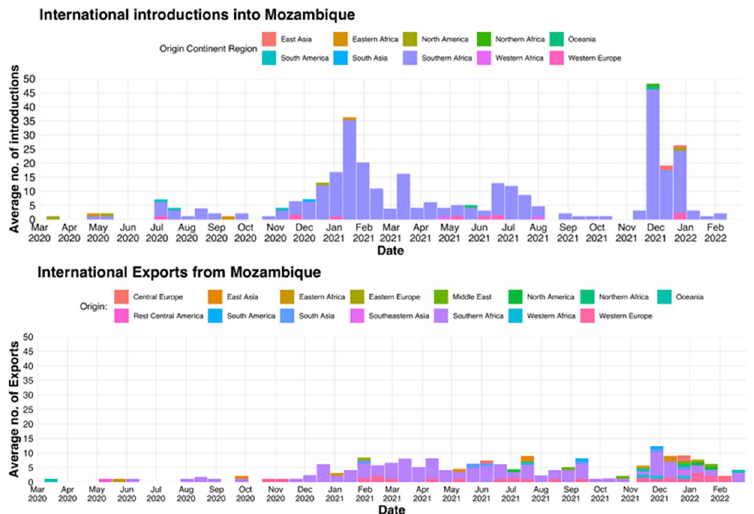
Fig 4. SARS-CoV-2 import and export events inferred for Mozambique. The bar charts illustrate the average number of SARS-CoV-2 introduction events (top), and the average number of export events